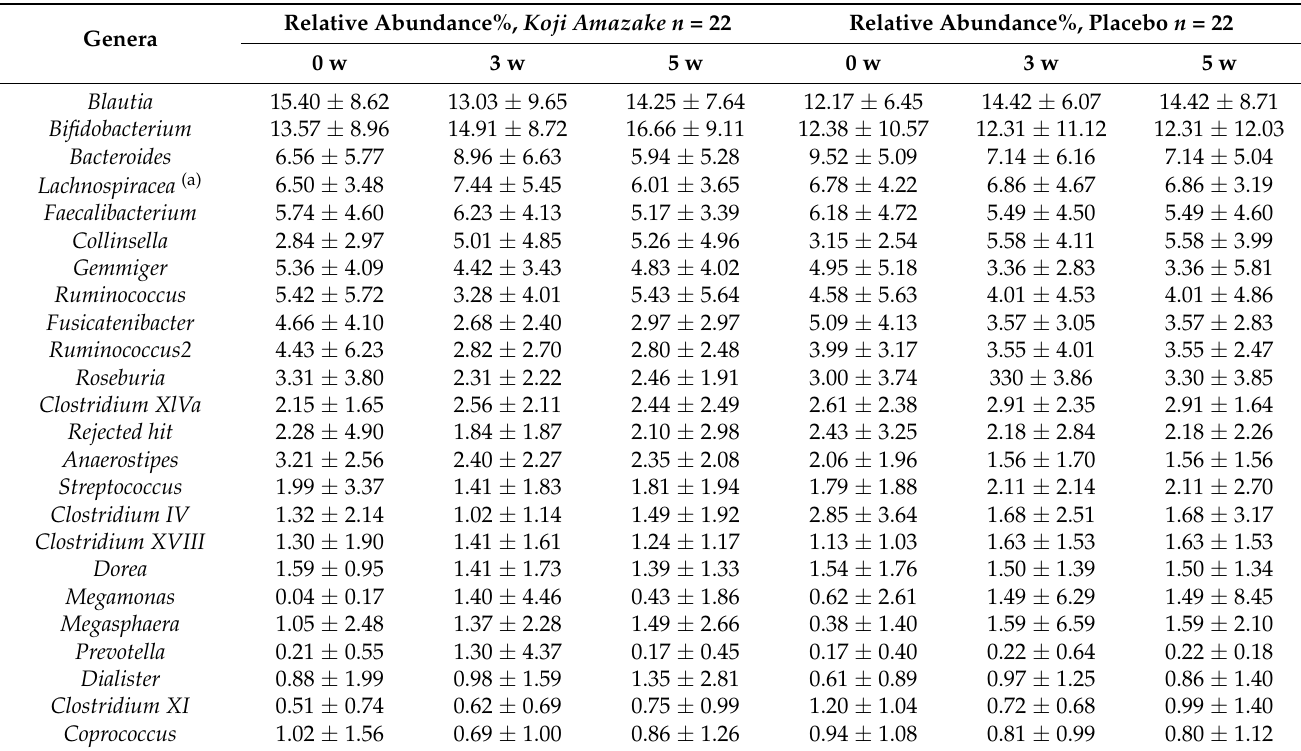
Table 4. Comparison of relative abundances at three time points (0 w, 3 w, and 5 w) of koji amazake and placebo groups in each bacterial genus with relative abundance more than